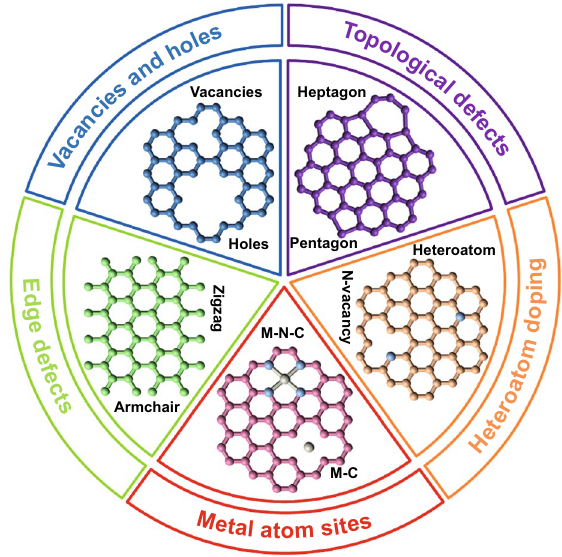
Fig. 2 Schematic illustration of the type of defective